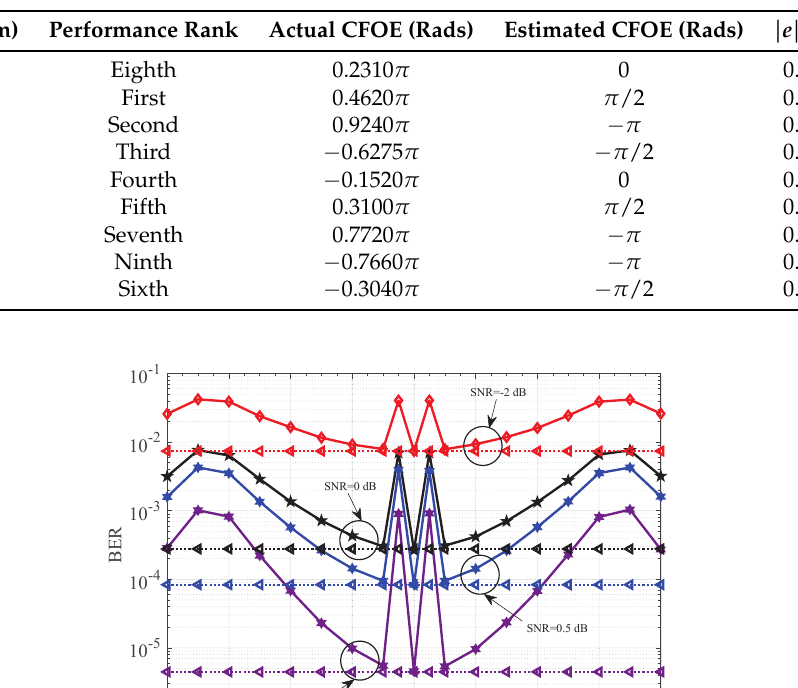
Table 3. Robustness analysis for the detector in [8]. CFOE: carrier frequency offset effect.